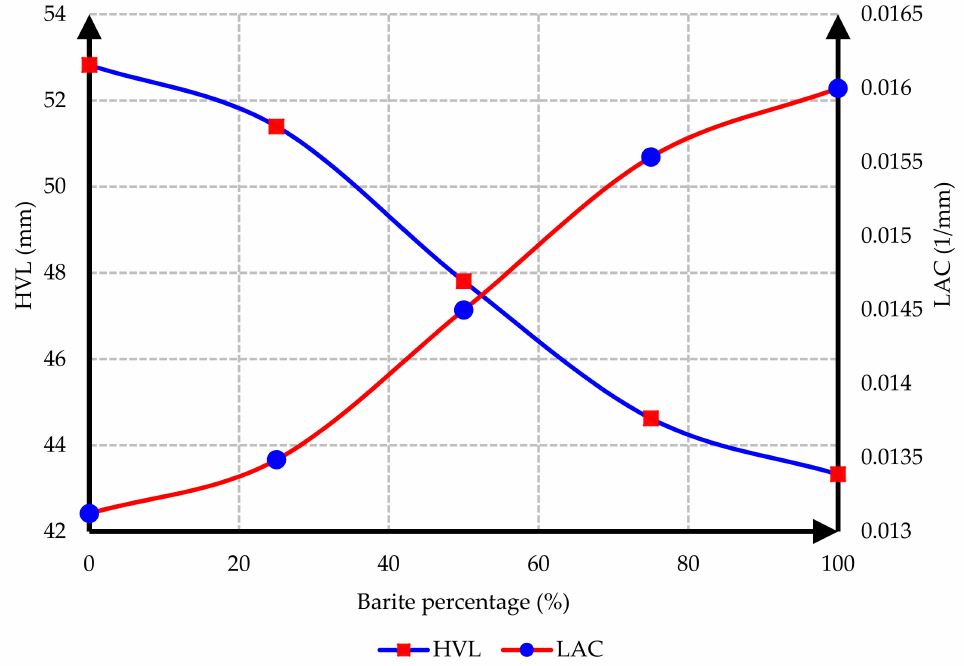
Figure 14. Interaction between the attenuation and the HVL for C25 concrete.